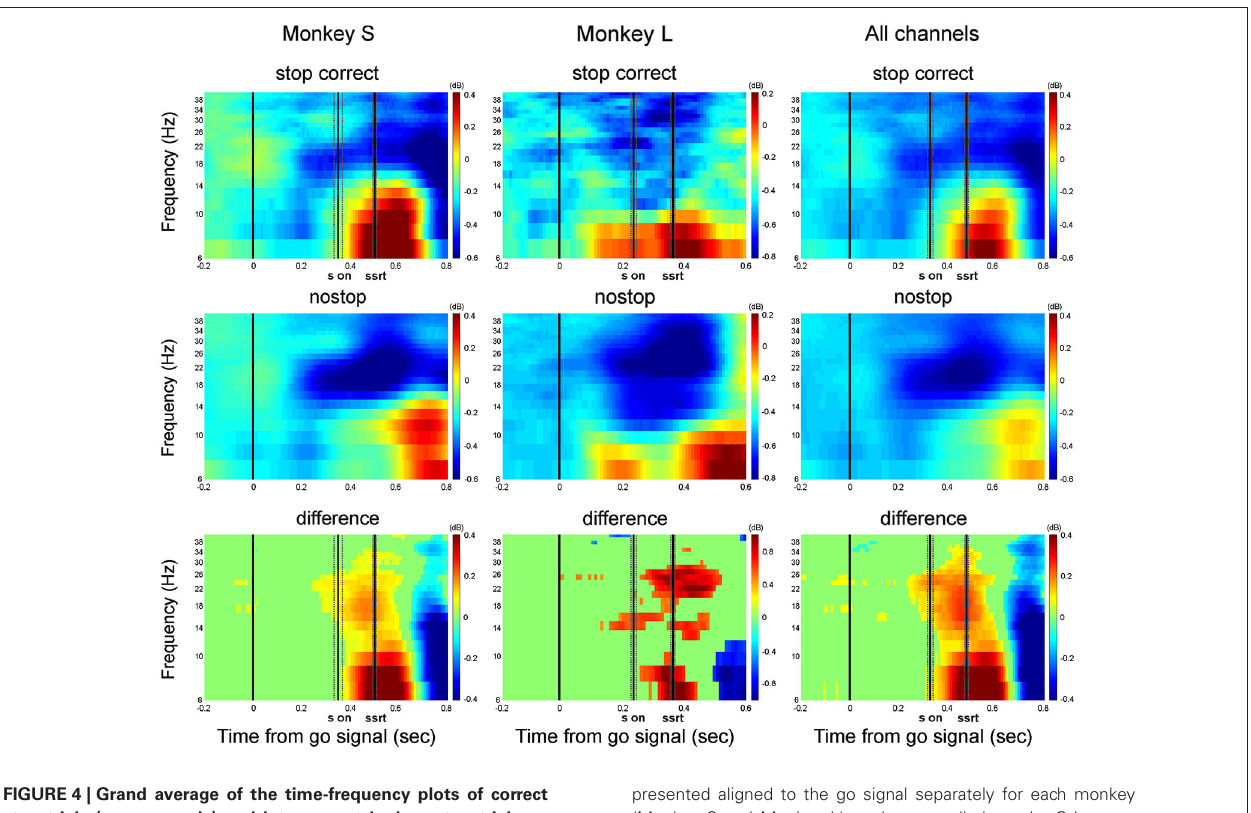
FIGURE 4 | Grand average of the time-frequency plots of correct stop trials (upper panels) and latency-matched no-stop trials (middle panels) and their difference (bottom panels) . Data are